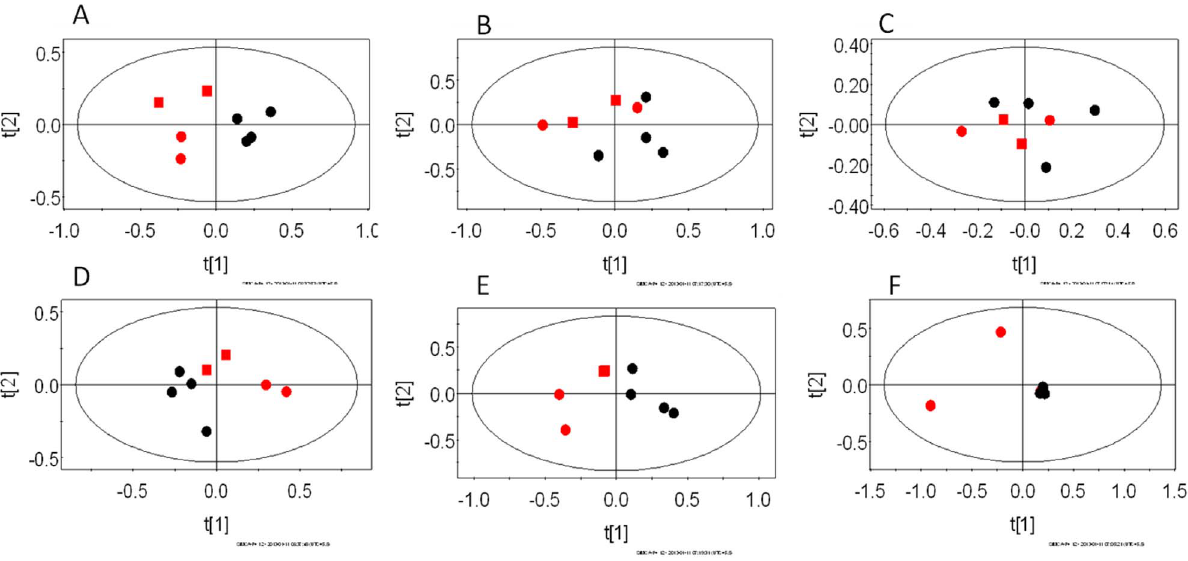
Figure 3. The PCA scores plots of 1 H NMR spectra of Balb/C mice infected with P.chabaudi illustrating the segregation of uninfected control animals from animals at the peak infection stage. The scores plots generated from PC1 and PC2 are illustrated here. The plots represent pair-wise models of different biological compartments. A–C females and D–F males. A and D - liver, B and E- serum, C and F–brain. In each plot, red symbols are uninfected control mice and black dots represent animals at peak infection stage. Among the red symbols, the squares represent the control mice sacrificed along with the peak infection animals and the circles represent the animals sacrificed with the three weeks post- parasite clearance stage animals.